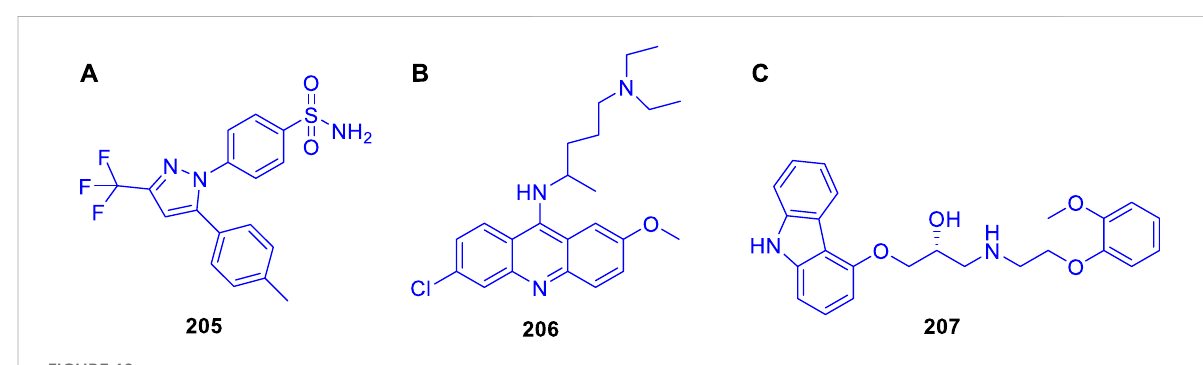
FIGURE 19 (A) Structures of celecoxib 205 , (B) Structure of quinacrine 206 , and (C) Structure of carvedilol 207